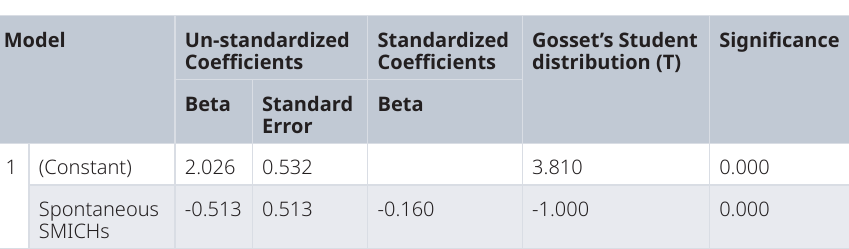
Table 4c. Coefficients.